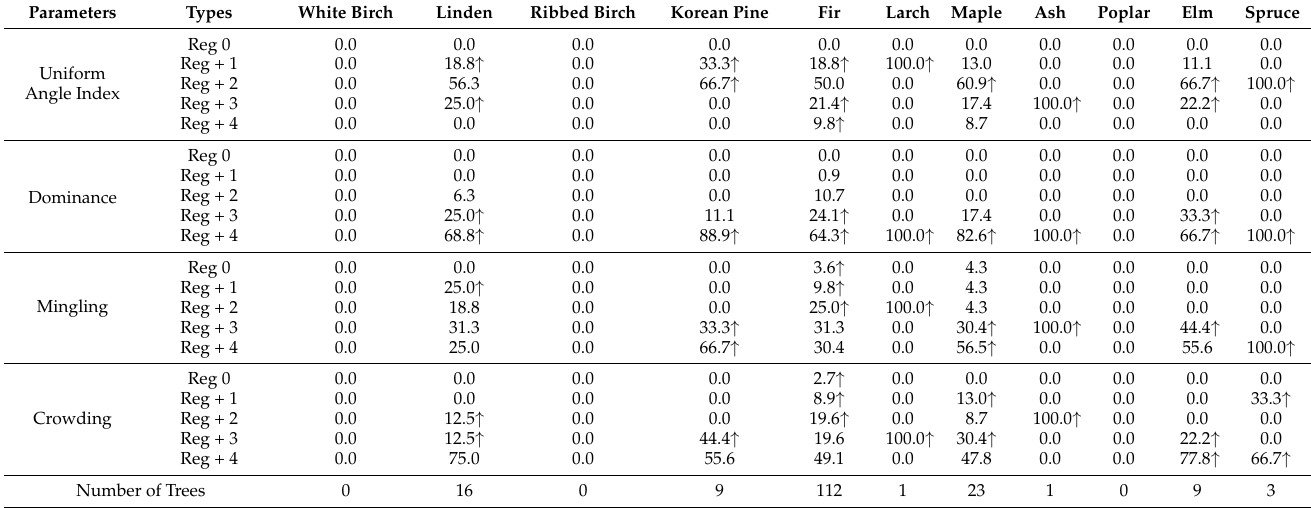
Table A3. The proportion statistics of change types of main tree species in recruitment process